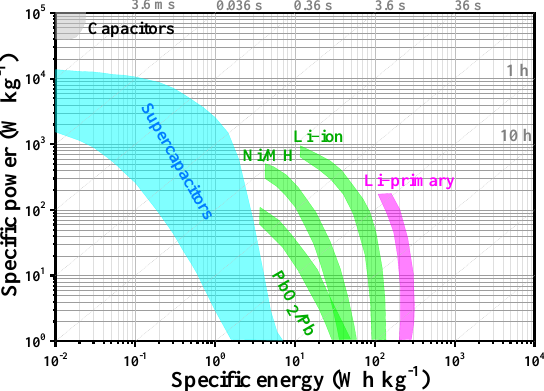
Figure 1. Ragone plot comparing the electrochemical properties of Li-primary battery, Li-ion battery, Ni/MH battery, PbO 2 /Pb battery, Supercapacitors [19]. Reprinted with permission from Reference [19]. Copyright 2021 Elsevier.